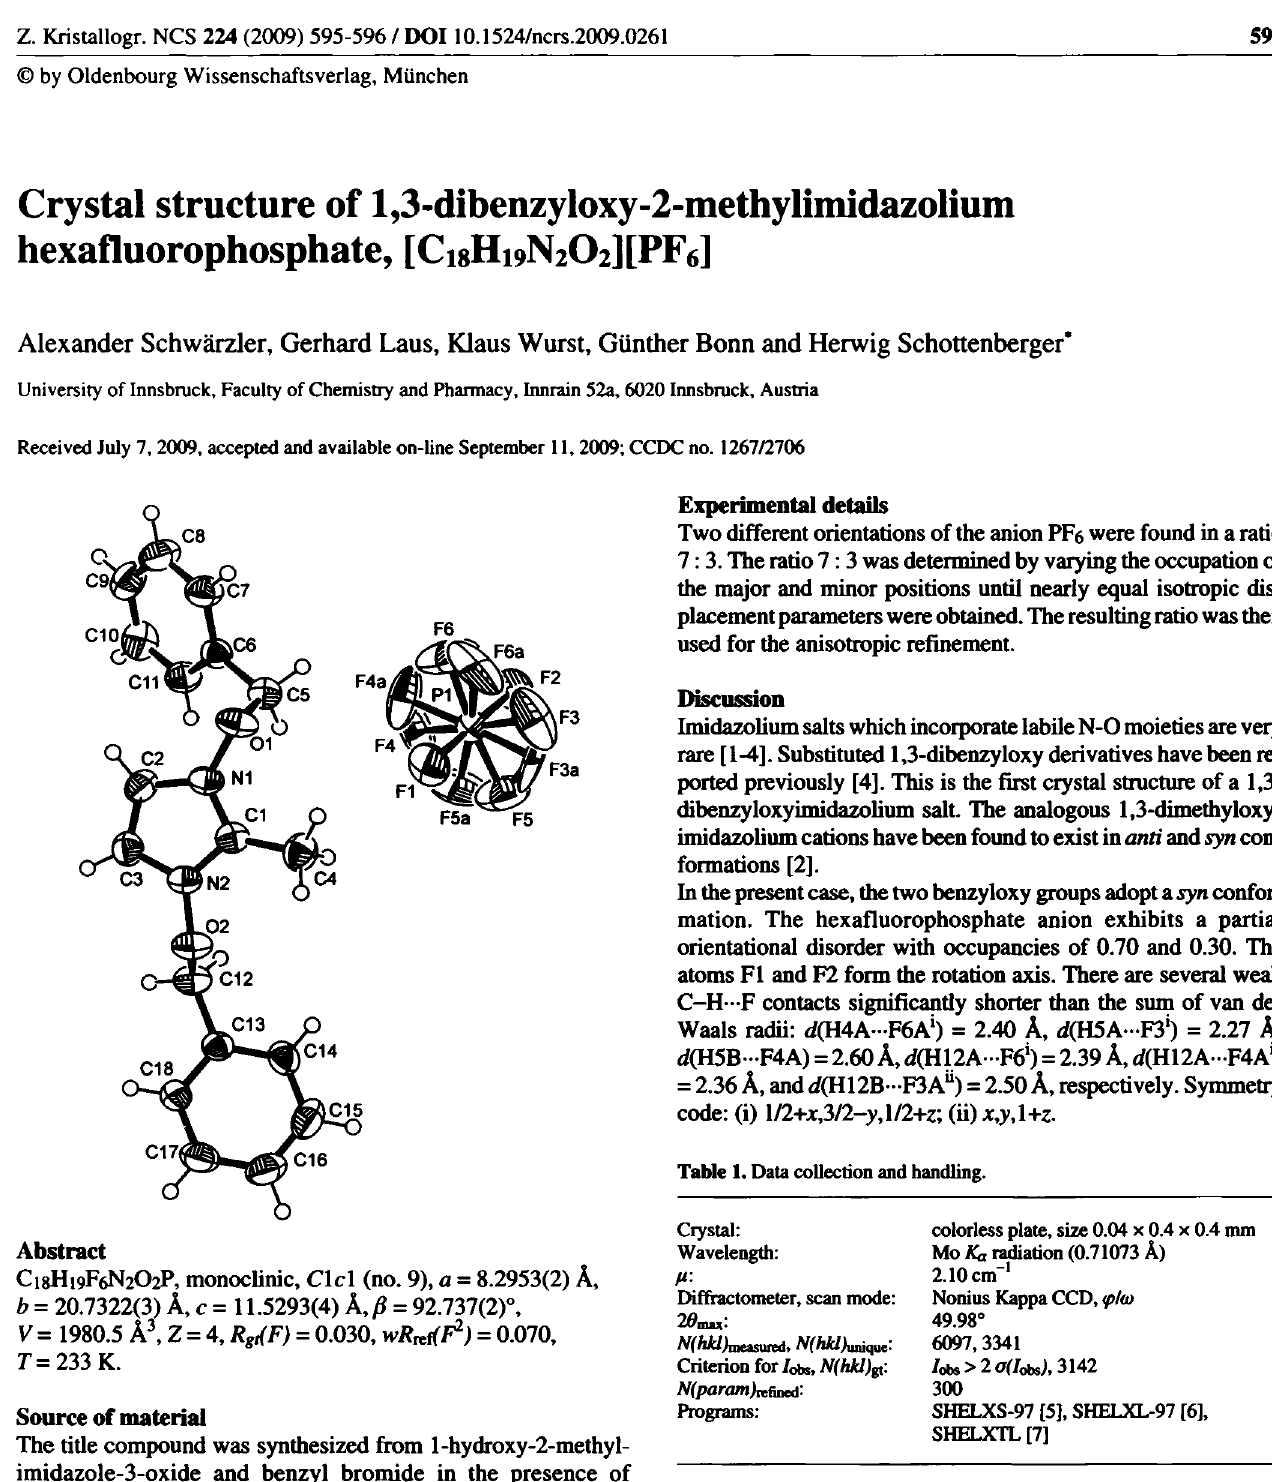
Table 2. Atomic coordinates and displacement parameters (in Â 2